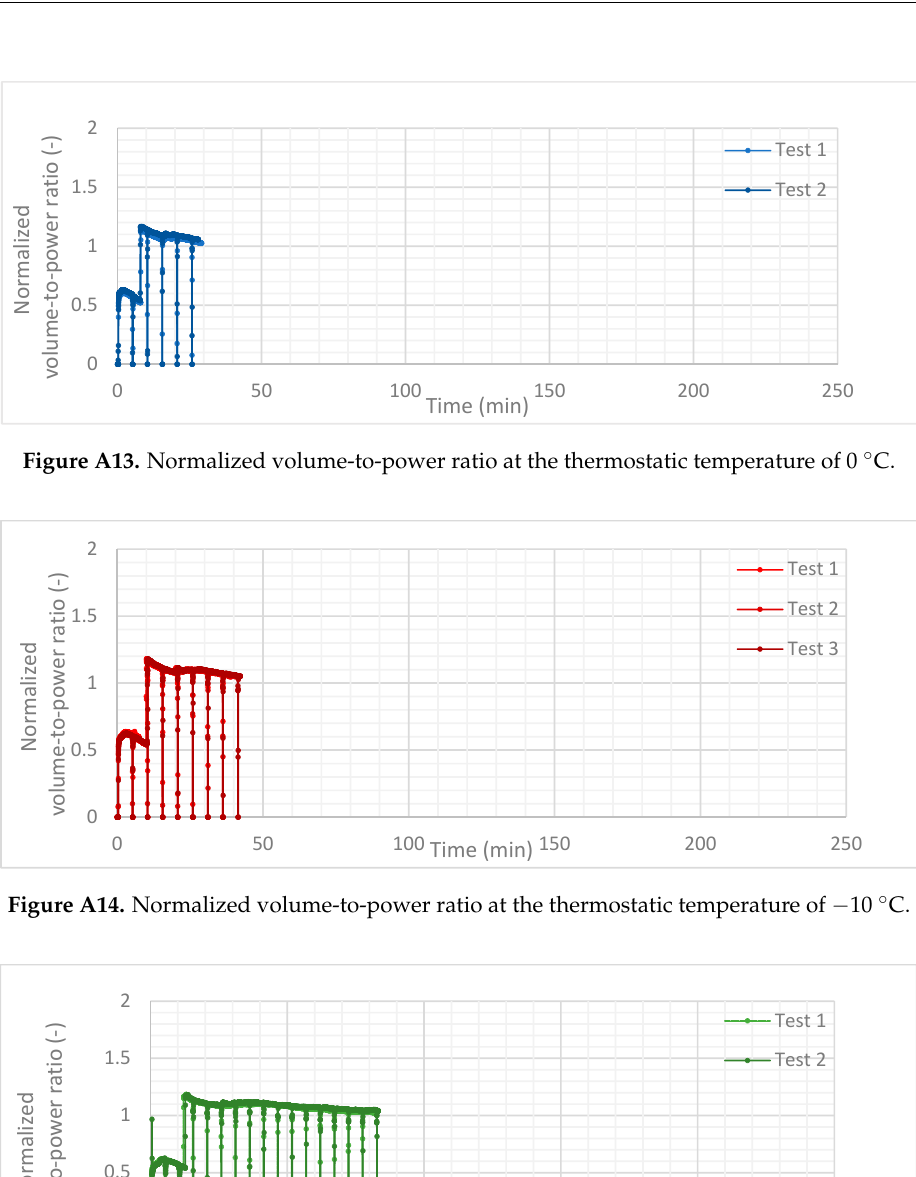
Figure A12. Normalized input power to the air compressor unit at the thermostatic temperature of